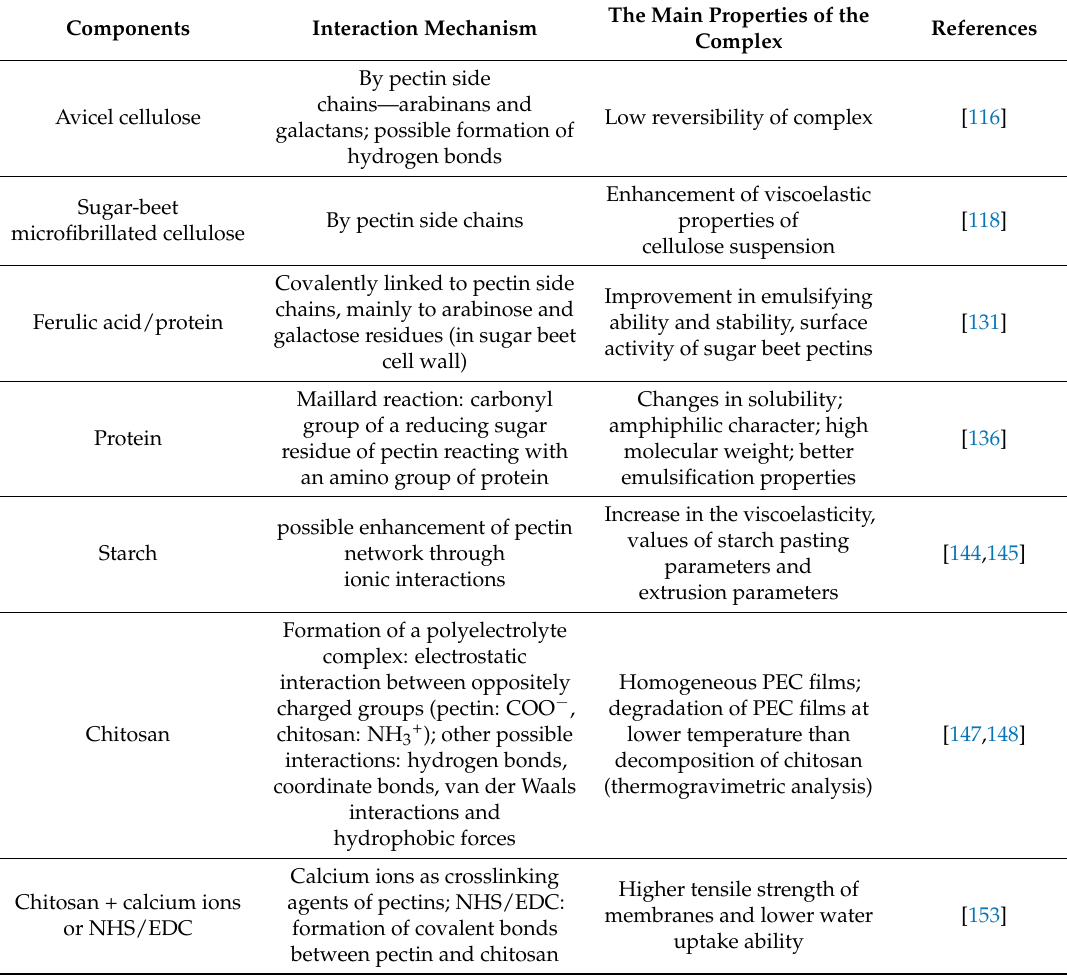
Table 2. Interaction mechanism and the main properties of systems of pectin with different